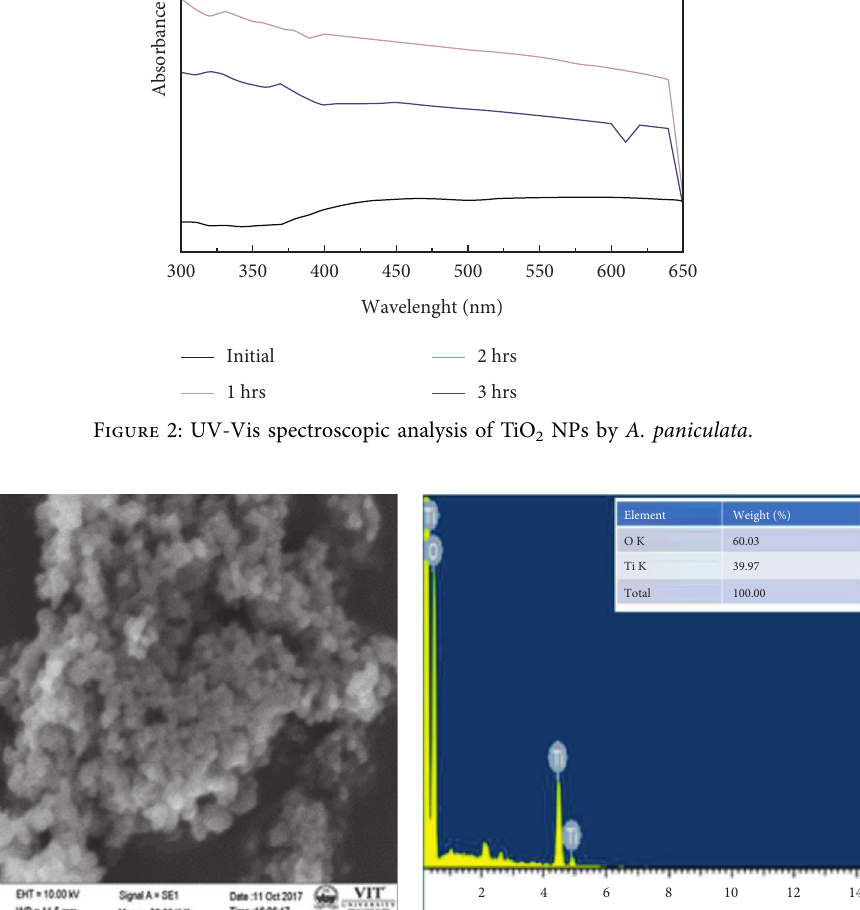
2 NPs by A. paniculata